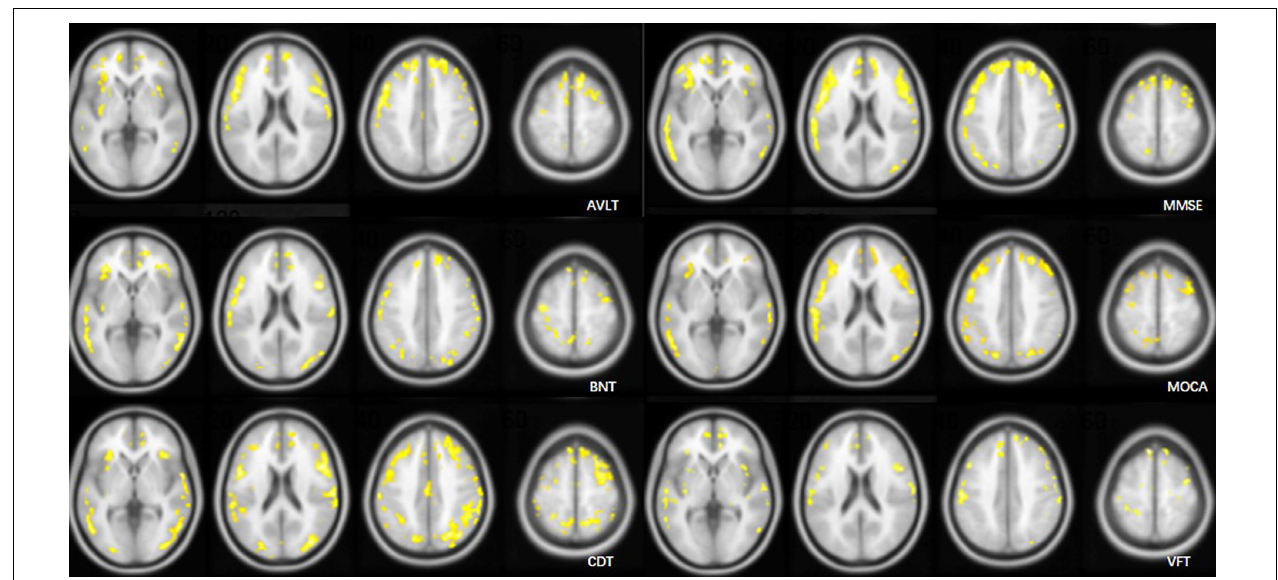
FIGURE 6 | Cluster maps overlaid on an MRI T1WI atlas. Clusters included > 100 voxels with a correlation coefficient ( R ) > 0.4 in voxel-wise relationship analysis of the AV1451 distribution and cognitive scores.